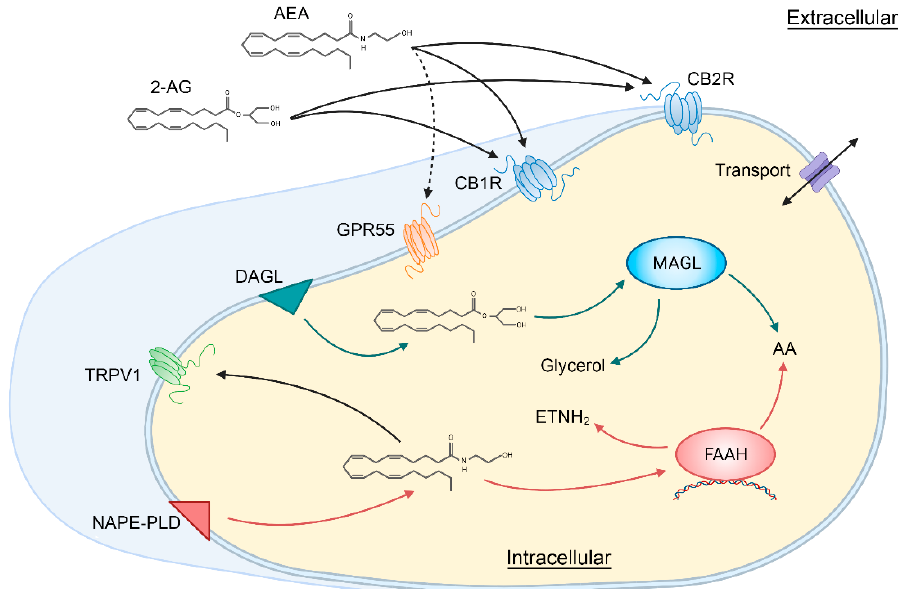
Figure 1. Schematic illustration showing the main components of the classical endocannabinoid system. 2-AG, 2-arachidonylglycerol; AA, arachidonic acid; AEA, anandamide or N-arachidonoylethanolamine; CB1R, cannabinoid receptor type 1; CB2R, cannabinoid receptor type 2; DAGL, Diacylglycerol lipase; ETNH 2 , ethanolamine; FAAH, fatty acid amide hydrolase; GPR55, G protein-coupled receptor 55; MAGL, monoacylglycerol lipase; NAPE-PLD, N-acyl phosphatidylethanolamine phospholipase D; TRPV1, transient receptor potential vanilloid type 1. Created with BioRender.com and based on [1].